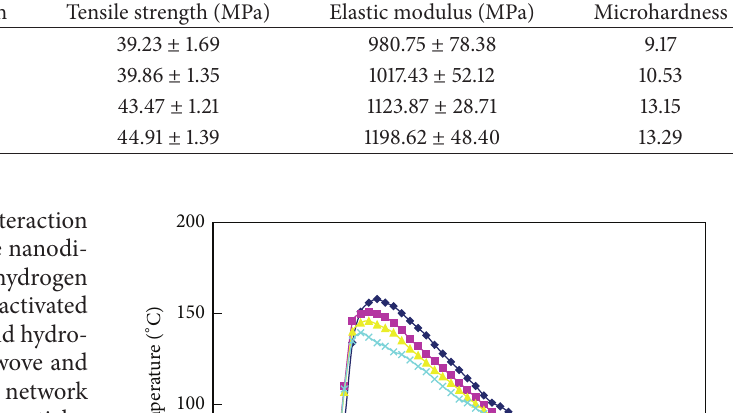
Table 1: Mechanical properties of the cured base material prepared with varying nanodiamond contents. Nanodiamond content (wt.%)